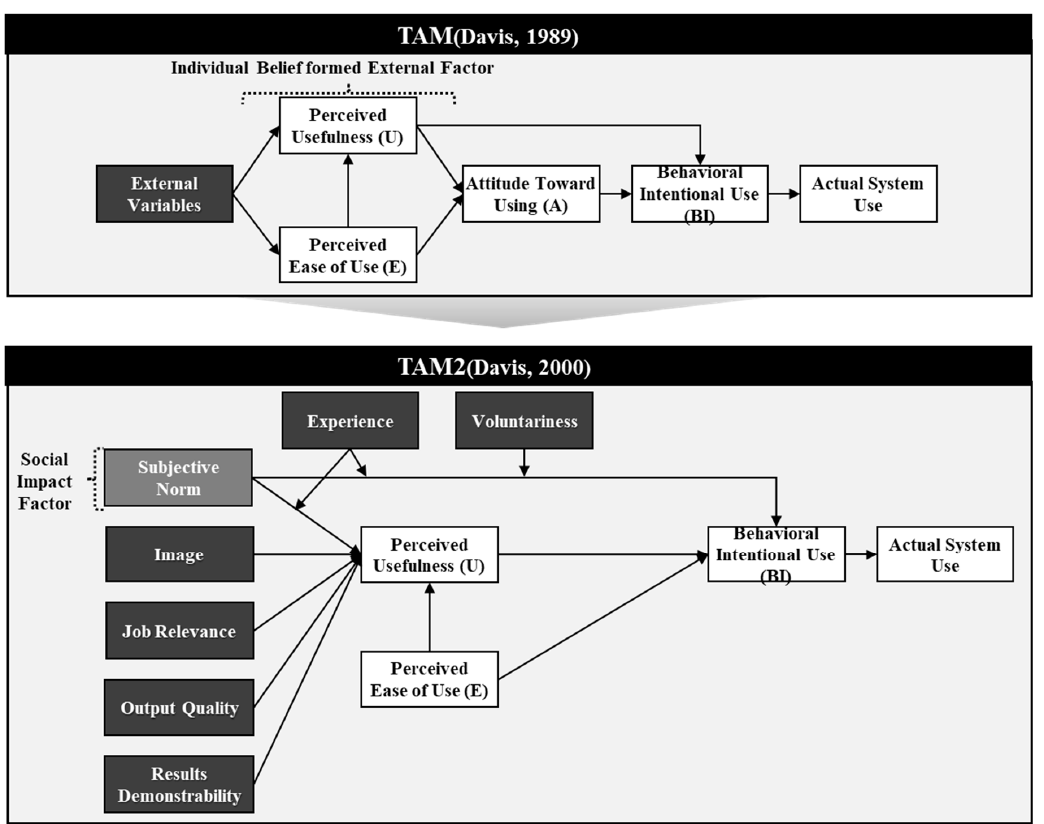
Figure 1. Davis’ Technology Acceptance Model (TAM) (1998, 2000).